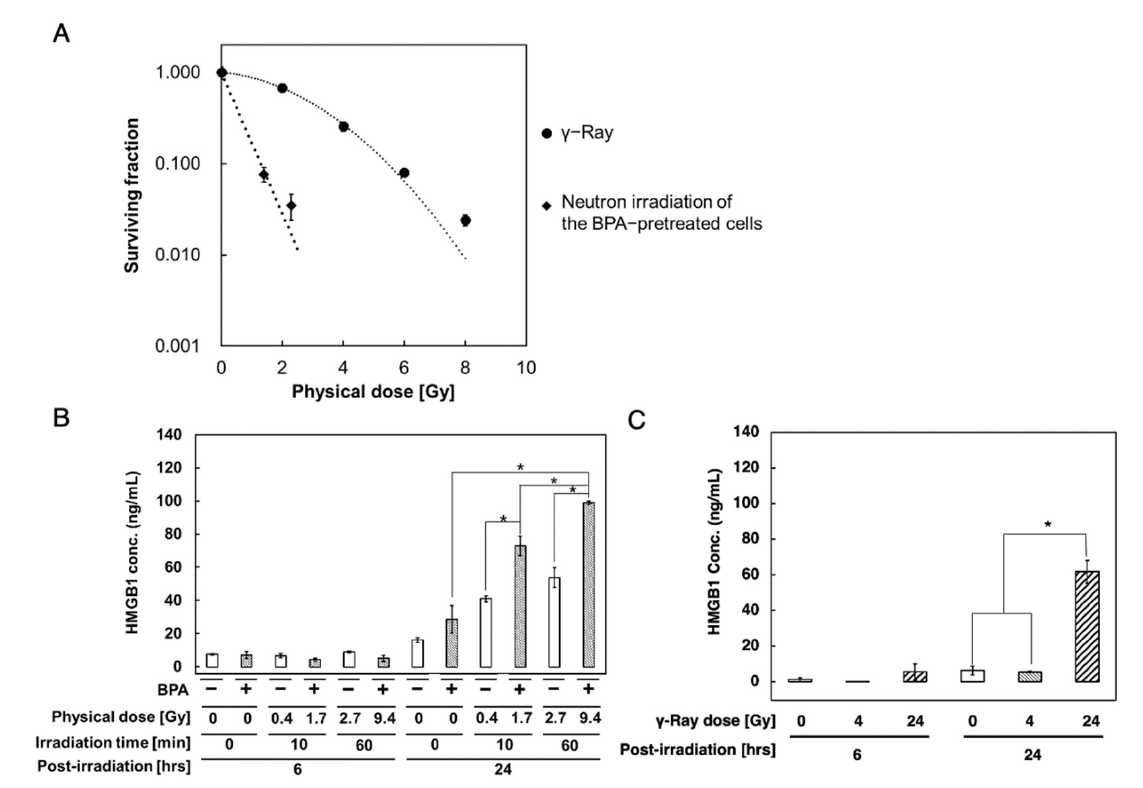
Figure 2. Increased HMGB1 levels in the culture supernatant of SAS cells after neutron beam irradiation with BPA compared with γ -irradiation. ( A ) Cell survival curves of SAS cells after neutron beam irradiation with BPA and γ -irradiation. SAS cells were treated with γ -irradiation (closed circle), neutron irradiation of the BPA-pretreated cells (closed diamond). The surviving fractions were assessed based on colony formation as described in the Materials and Methods. ( B , C ) Analysis of the HMGB1 level in the culture supernatant of SAS cells after neutron beam irradiation with BPA ( B ) and γ -irradiation ( C ) with ELISA (( B ) SHINOTEST, ( C ) Abnova)). BPA at 25 ppm [ 10 B] or the control was added 1 h before neutron beam irradiation for BNCT. The background value of the medium was subtracted from each data point. Replicates n = 3 in ( A – C ). ( B , C ) Mean ± S.E. *, p < 0.05. Student’s t -test.